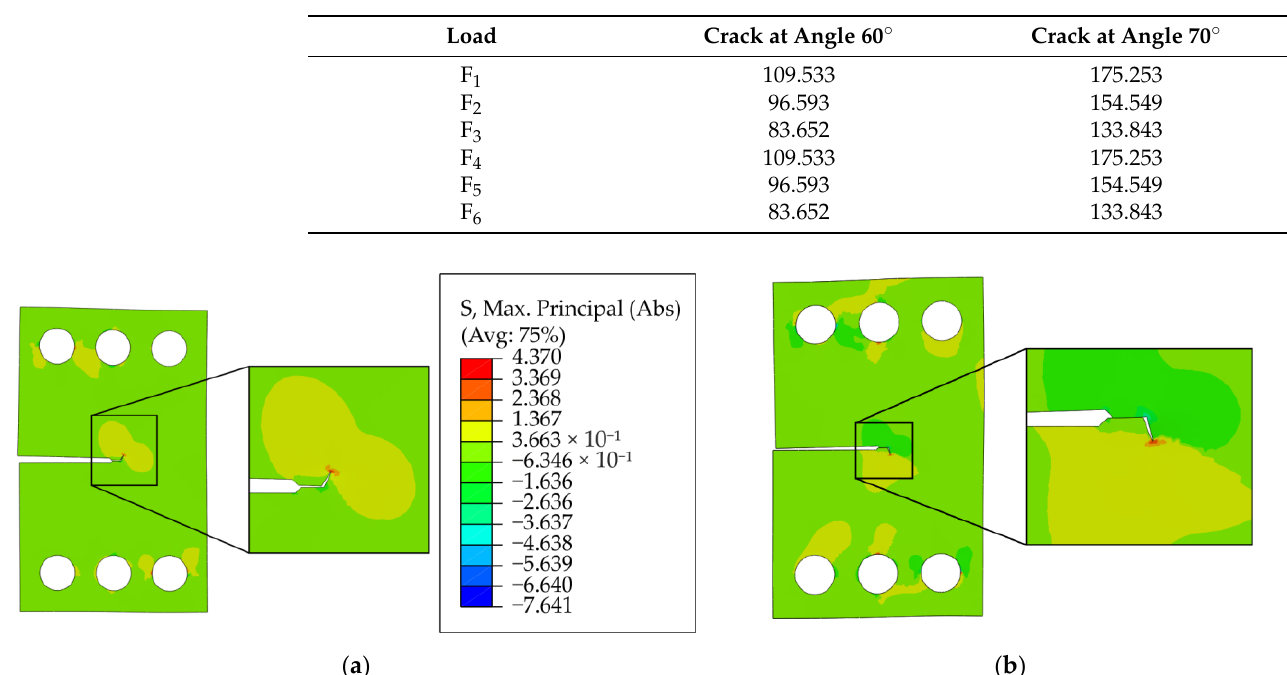
Figure 13. Models of CTS specimen with cracks and loading situations: ( a ). Crack deflected upwards at 60°; ( b ) Crack deflected downwards at 70°. Table 2. The loads in newton for the CTS specimens presented in Figure 13.